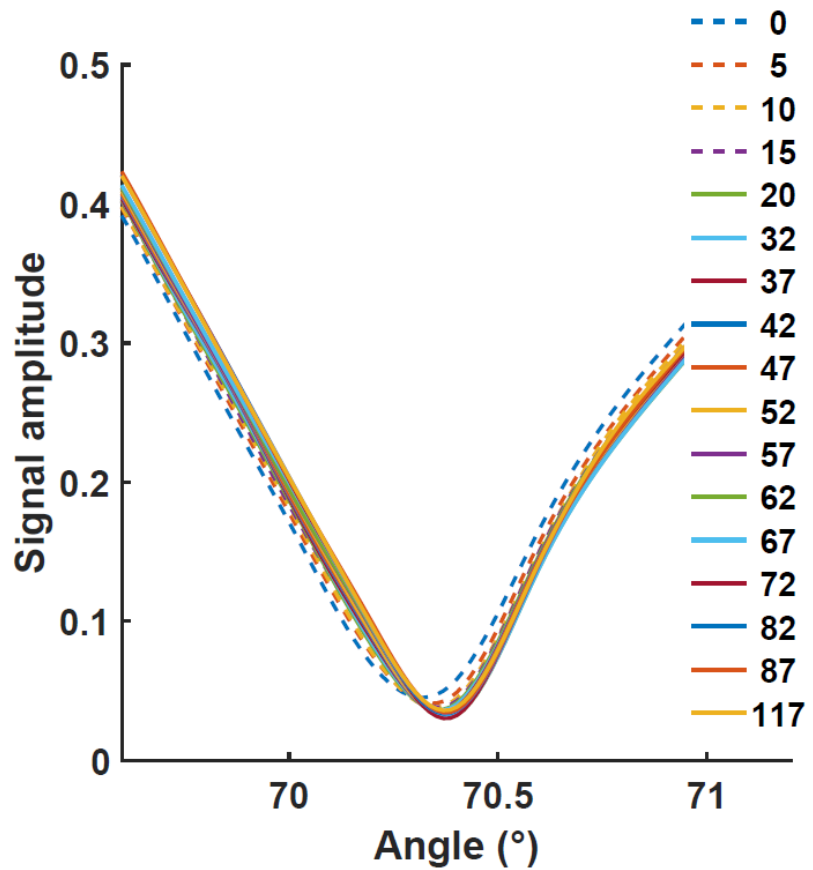
Figure 7. SPR curves for Cu thin films deposited on glass (46 nm) protected by 5 nm Al 2 O 3 being in contact with 20 mM PBS. The time is given in minutes in the legend.